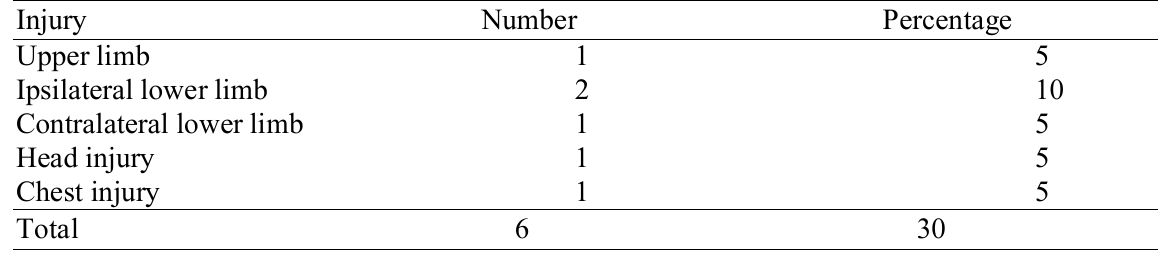
Table 5: concomitant injuries (6/20,